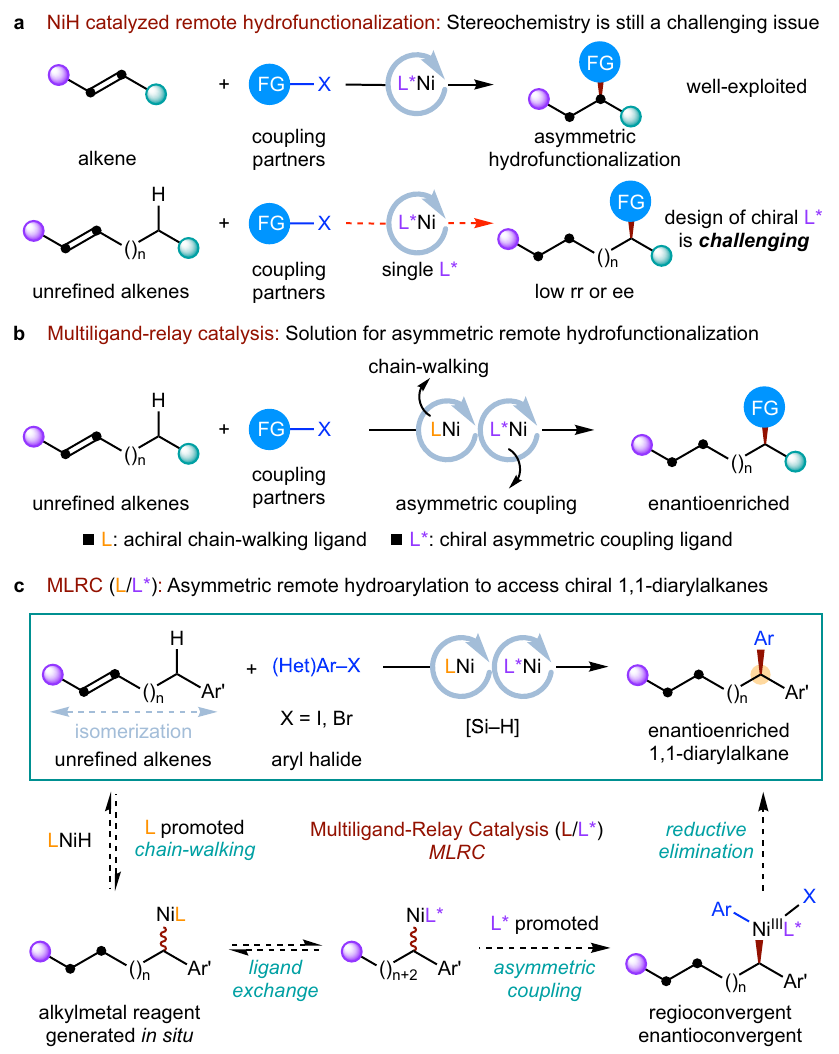
Fig. 1 Design plan: Synergistic combination of a chain-walking ligand (L) and an asymmetric arylation ligand (L*) to access chiral 1,1-diarylalkanes. a Stereochemistry in remote NiH catalysis is still a challenging issue. b Multiligand-relay catalysis as a solution for asymmetric remote hydrofunctionalization. c Ni-catalysed multiligand-relay catalysis to access chiral